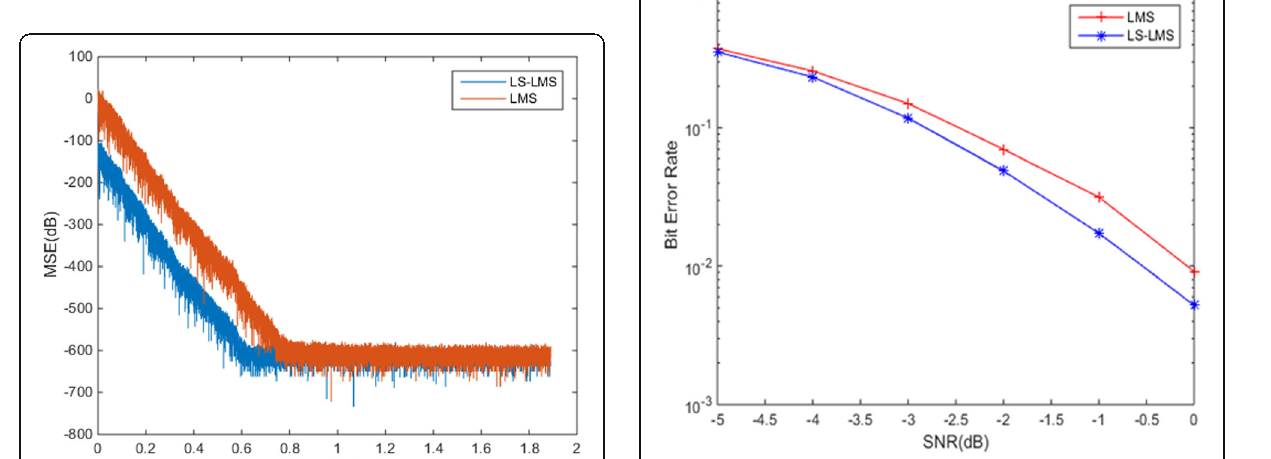
Fig. 8 BER performances comparison between the referred two